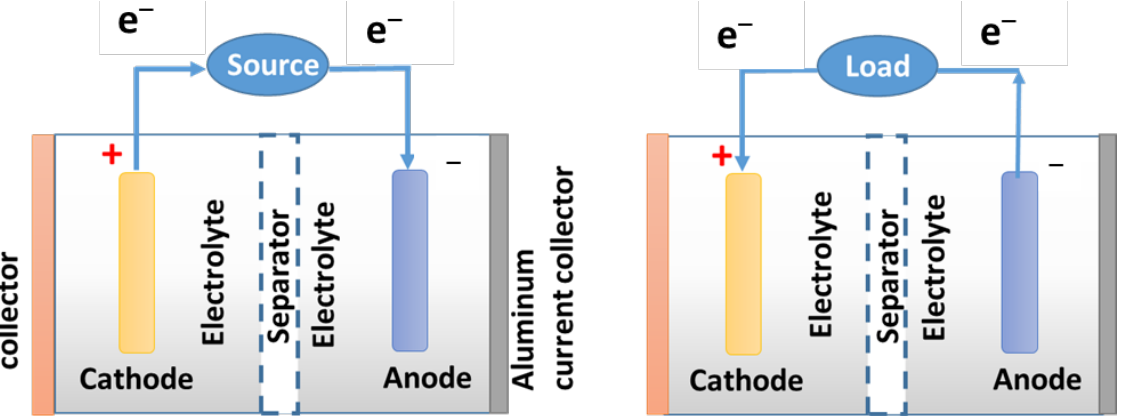
Figure 1. Charge ( left ) and discharge ( right ) of a conventional rechargeable battery. Different Li-ion cathodes have been developed (Table 6) but the anode is often based on carbon (graphite or microspheres) because carbon can reversibly absorb and release a large quantity of Li (Li:C) = 1:6 as discussed earlier.